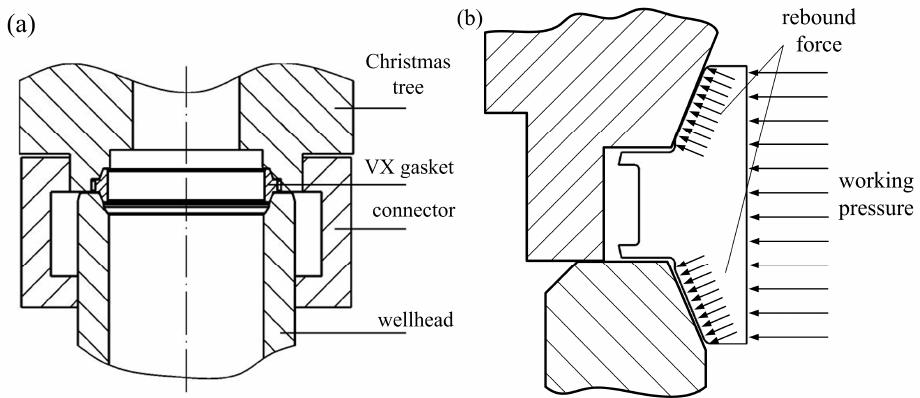
Figure 1. A subsea Christmas tree wellhead connector: ( a ) sealing structure; and ( b ) sealing